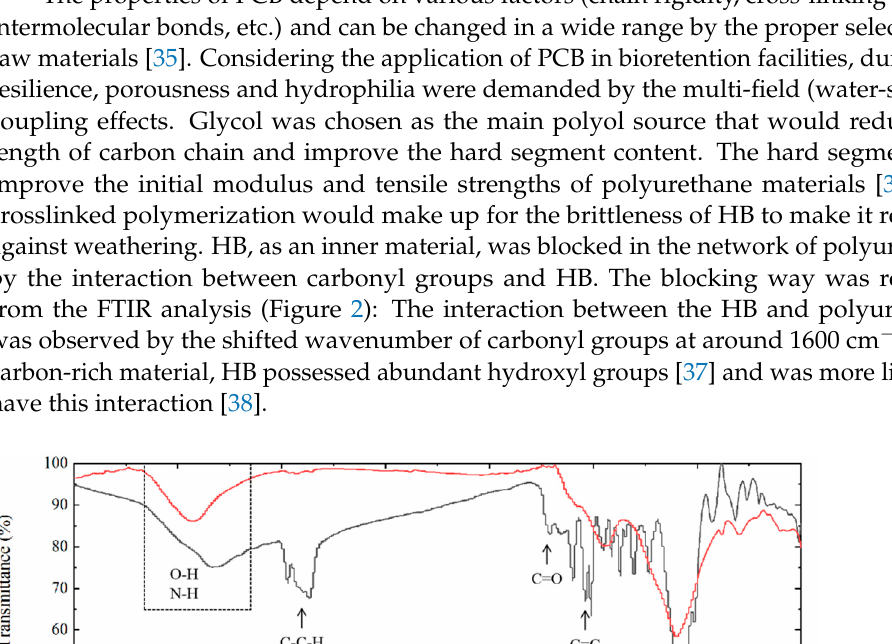
Figure 1. The reaction of polyurethane-biochar crosslinked material (PCB) via the one–shoot method with the addition of HB.